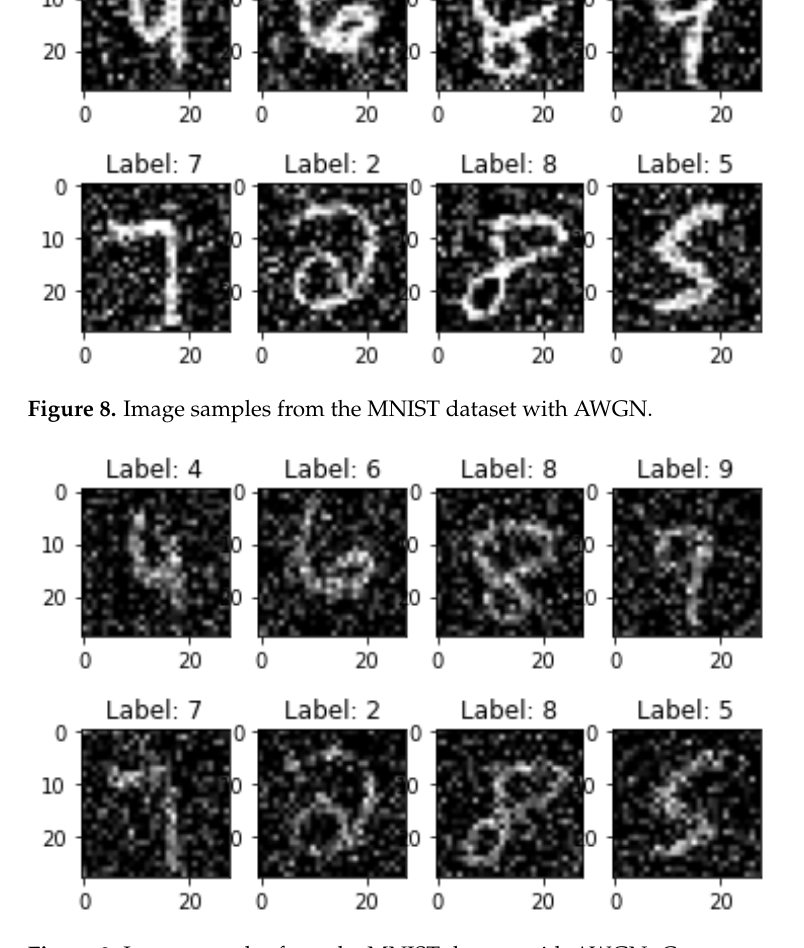
Figure 9. Image samples from the MNIST dataset with